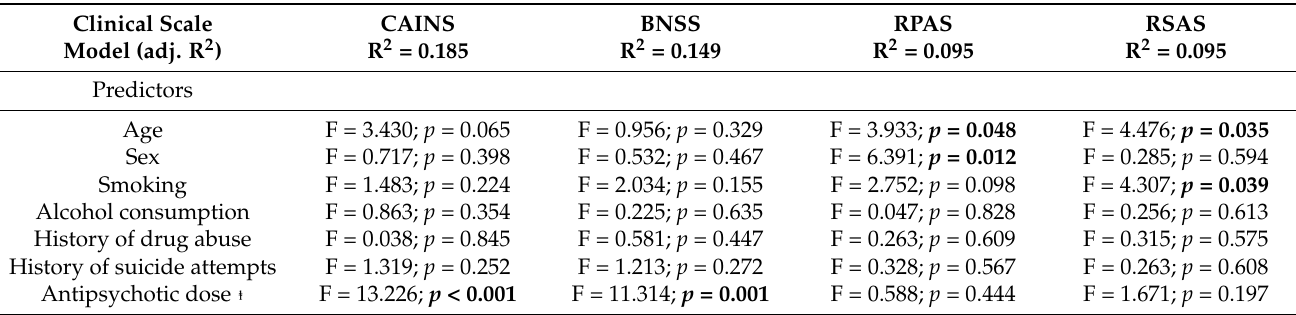
Table 2. The effect of demographic and clinical data on global functioning, severity of schizophrenia, depression, negative symptoms, and physical and social anhedonia in patients with schizophrenia, evaluated with a general linear model. p values in bold represent statistical significance.